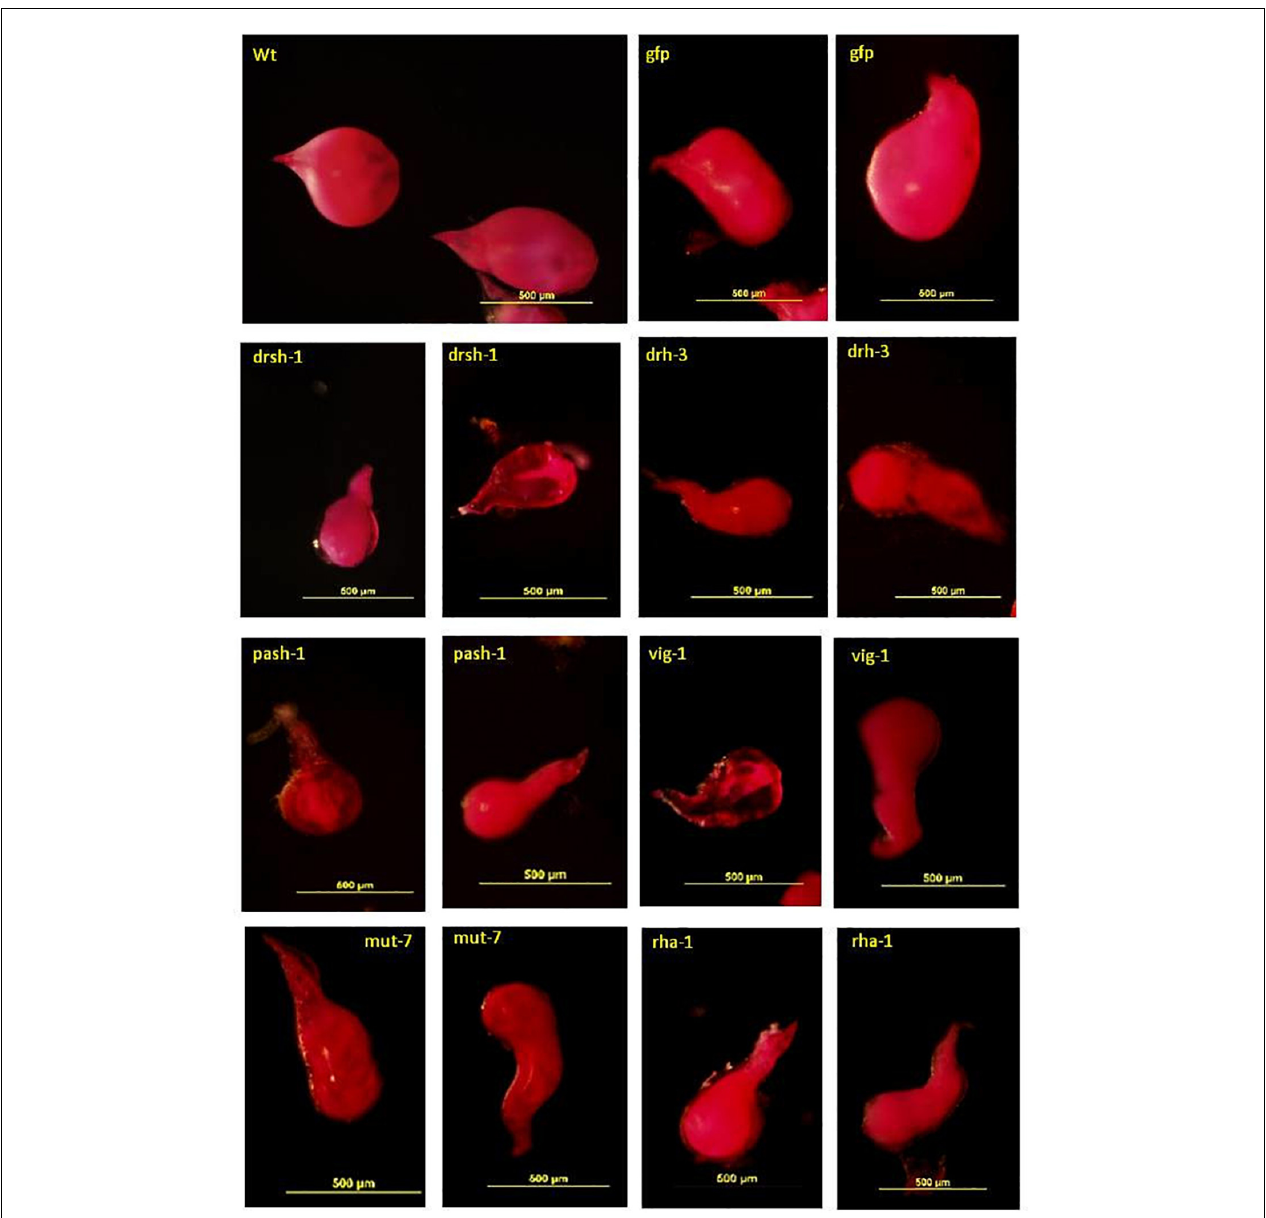
FIGURE 6 | Malformation in Acid Fuchsin-stained M. incognita females isolated from transgenic plants expressing hairpins of nematode genes. Scale bar: 500 µ